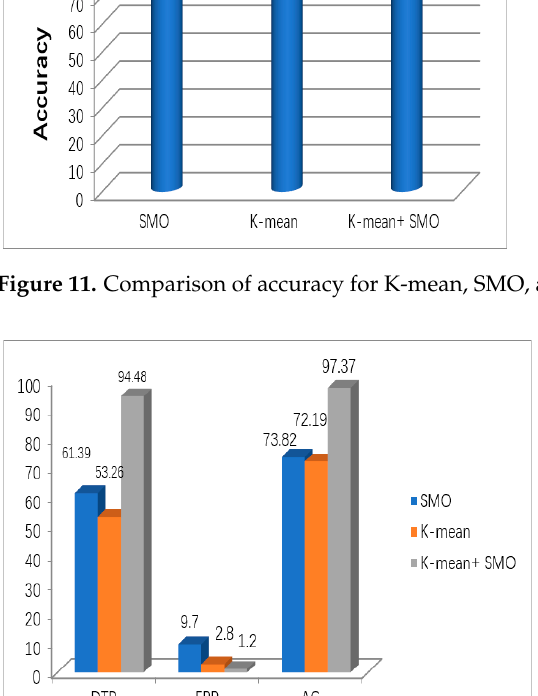
Figure 12. Benchmarking for K-mean, SMO, and SMO jointly with the K-mean data mining of meas- urement parameter.